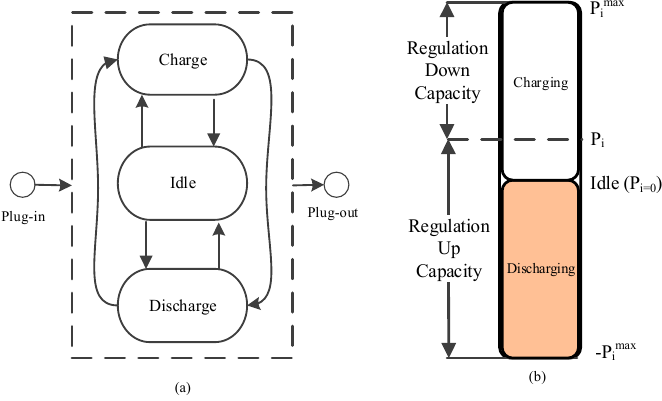
Figure 2. ( a ) Three-state EV model; and ( b ) regulation capability of single EV.